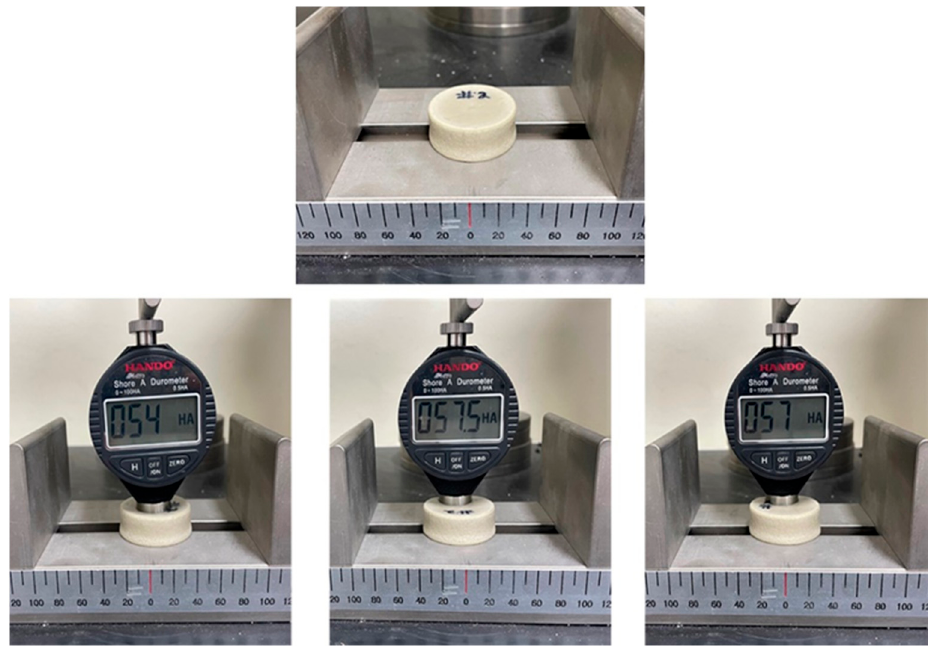
Figure 7. Shore A hardness value of the microcellular foamed ceramic urethane.